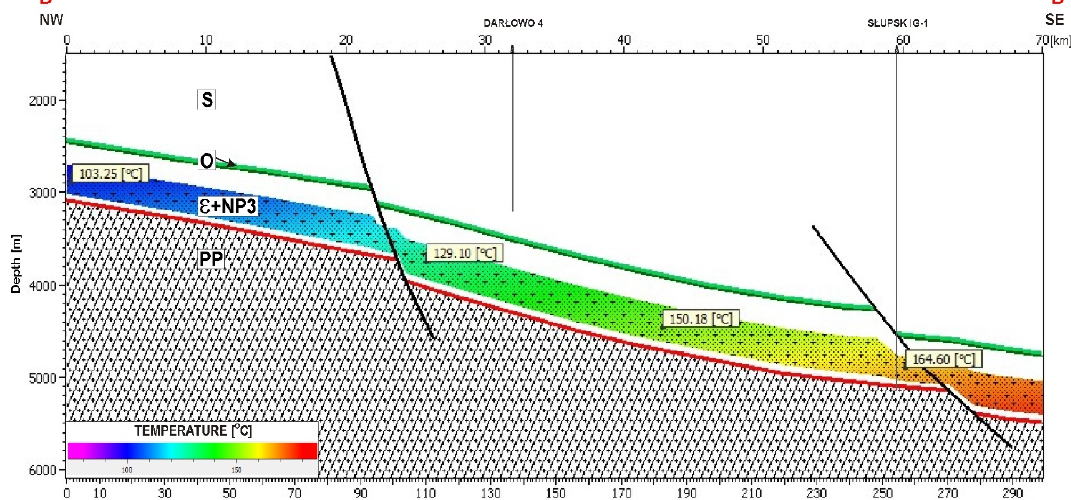
Figure 12. Model of temperature distribution in Ediacaran–Lower Cambrian sandstones. Stratigraphic symbols as in Figure 3.